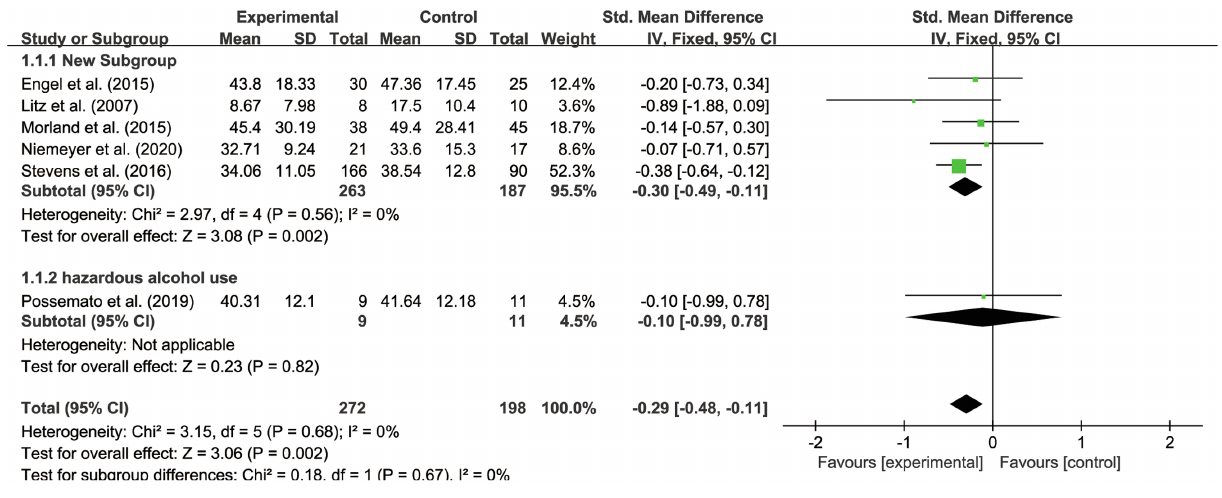
FIGURE 6 | Forest plot of effects of IBI on veterans with different comorbidity.